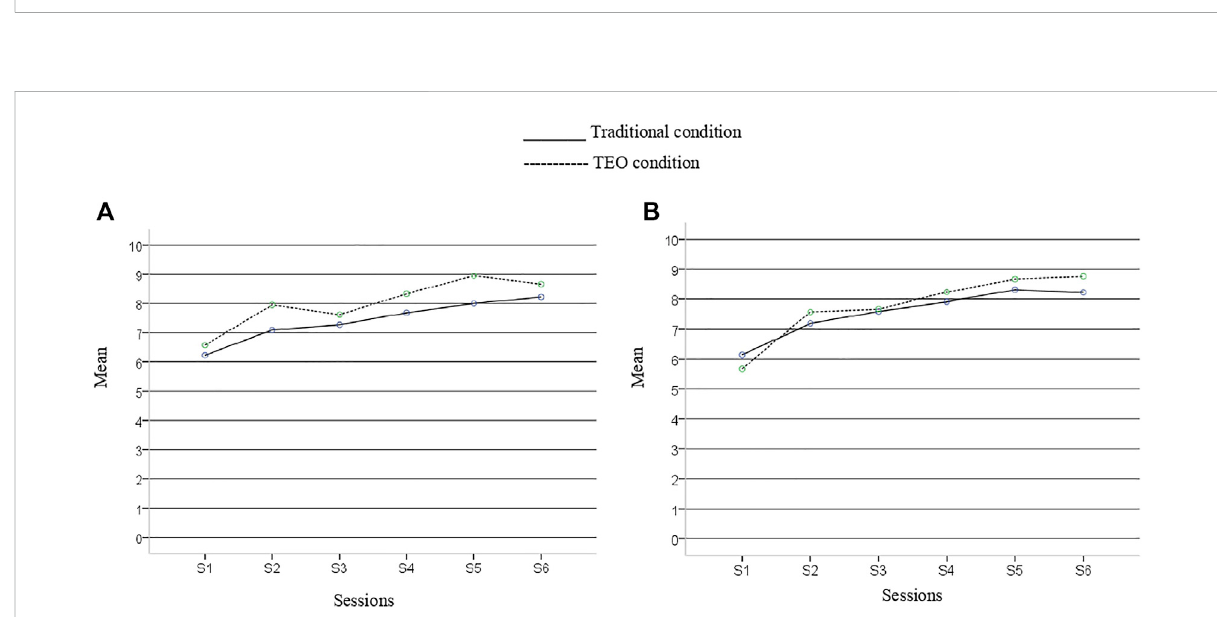
FIGURE 6 Satisfaction (A) and usefulness (B) of each homework assignment session.